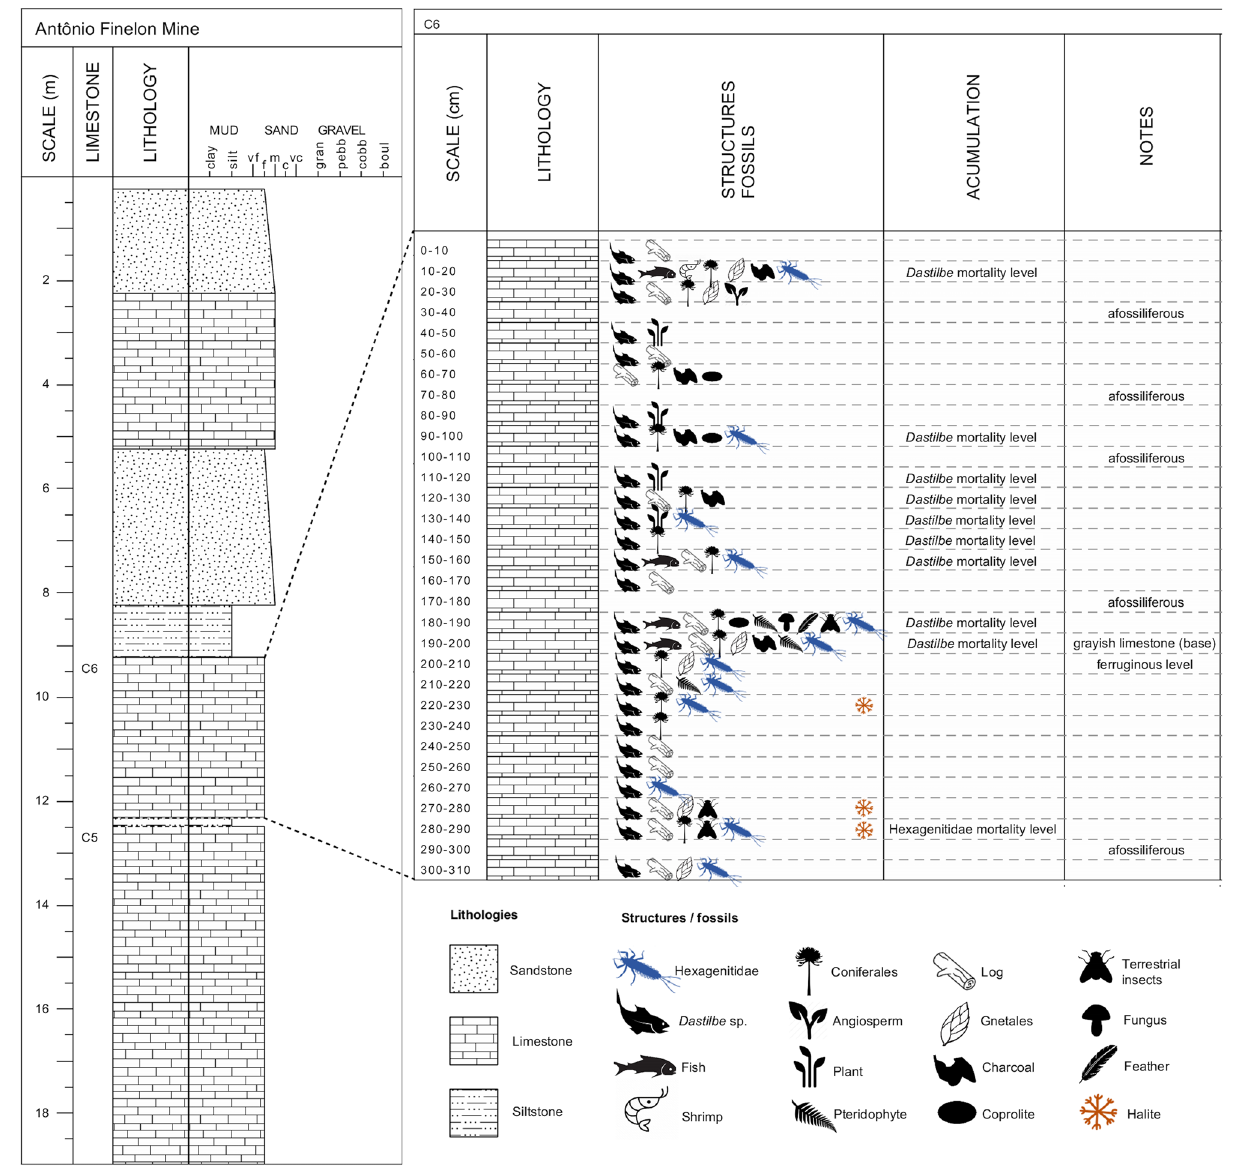
Figure 2. Excavation profile of an outcrop of the Crato Formation. Antônio Finelon Mine, Nova Olinda municipality, Ceará State, Brazil. On the right, the section excavated of 3.10 m in depth, at level C6, evidencing the lithostratigraphic position of the fossil assemblage and levels with fossil